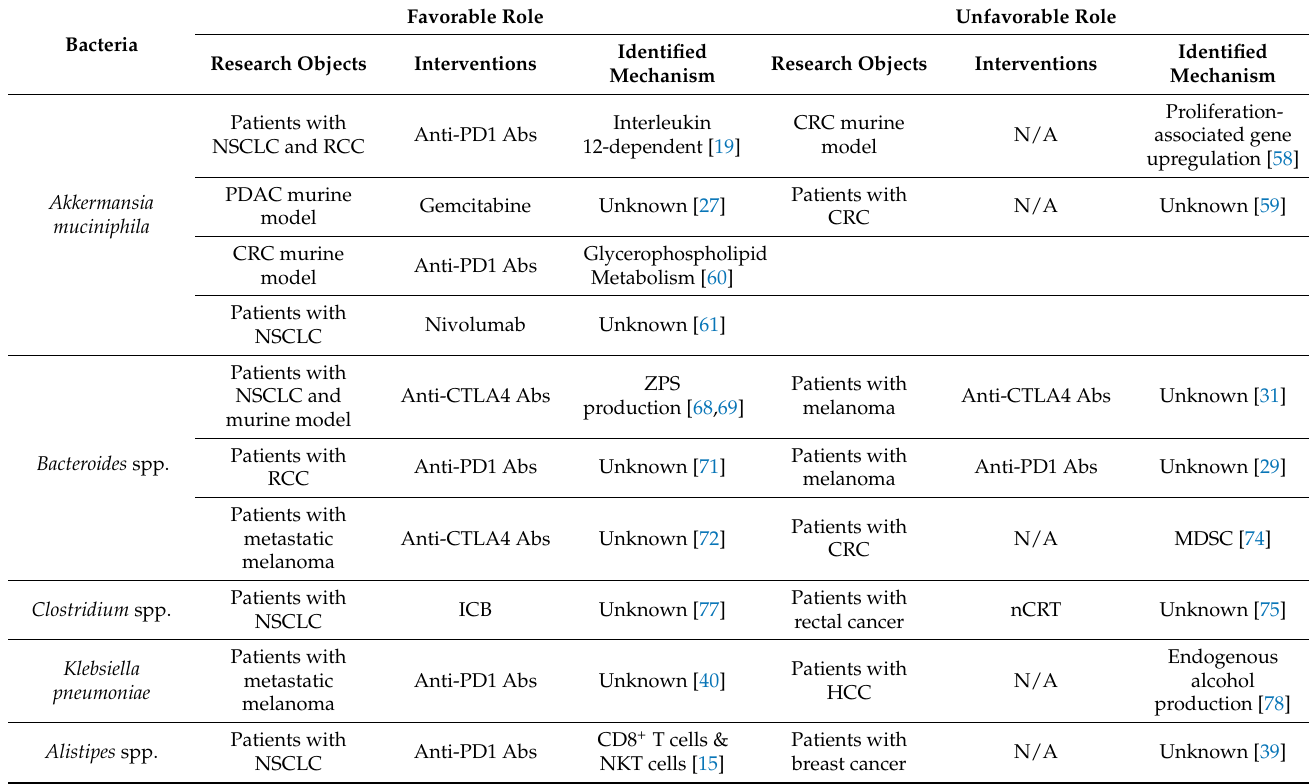
Table 3. The bacteria observed with both favorable and unfavorable modulation in antitumor